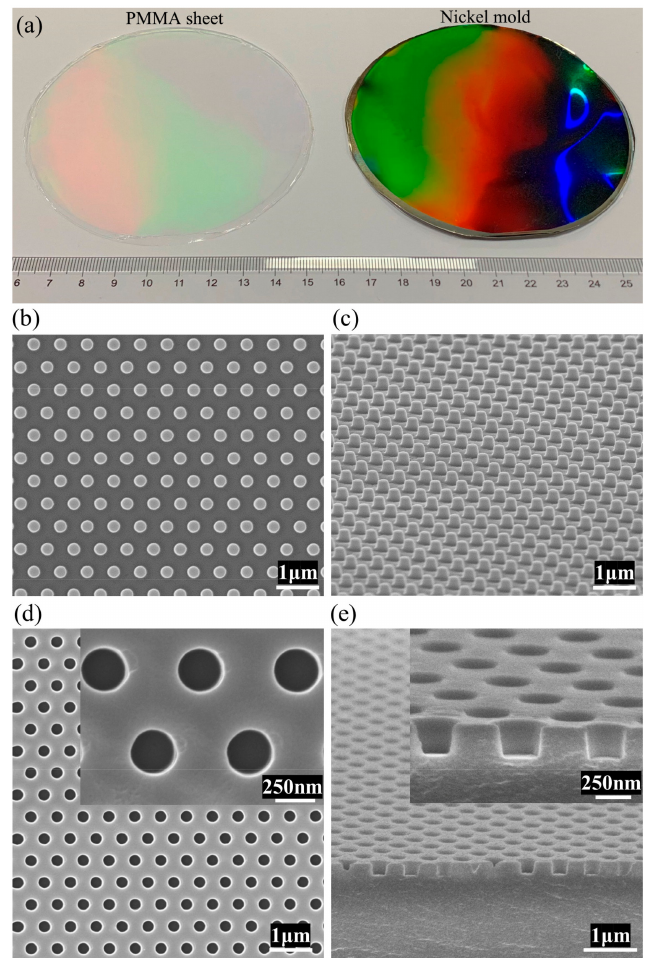
Figure 6. ( a ) Photograph of the 4-inch diameter nickel mold (right) and nanopatterned PMMA sheet fabricated through our rapid imprint apparatus (left); ( b ) top-viewed scanning electron microscope (SEM) image of the nickel mold; ( c ) tilted-viewed SEM image of the nickel mold; ( d ) top-viewed SEM images of the imprinted PMMA sheet; and ( e ) tilted-viewed SEM images of the imprinted PMMA sheet’s cross